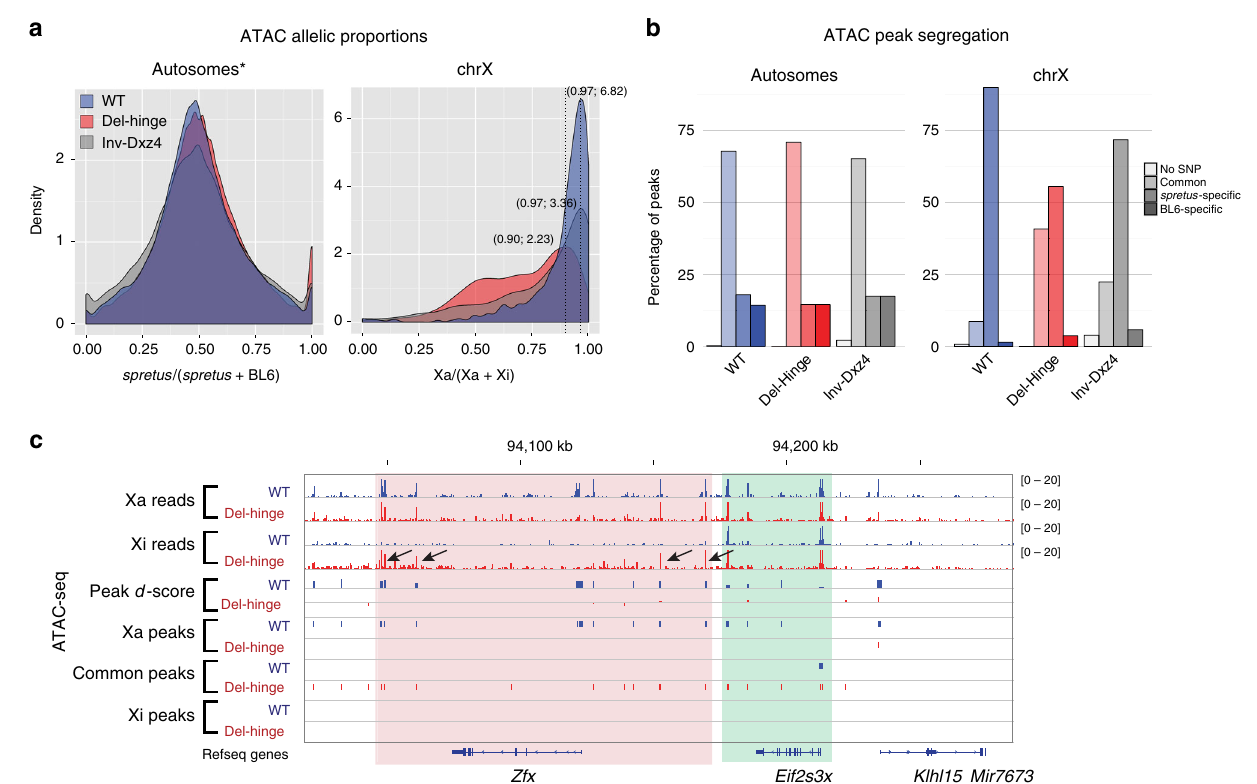
Fig. 7 ATAC peak distribution on the Xi in Del-hinge and Inv-Dxz4. a As in Fig. 6a but for ATAC peaks. A shift in the distribution of allelic proportions due to an increase in ATAC peaks on the Xi is evident for the X chromosome in Del-hinge and to a lesser extent Inv-Dxz4, compared to WT. b As in Fig. 6b but for ATAC peaks. c As in Fig. 6c but for ATAC peaks. Note that the location of peaks that appear around Zfx (arrows) in Del-hinge differ from that of the CTCF peaks. See additional analyses in Supplementary Fig. 7 – RNA-FISH for Xist showed that the majority of nuclei had one cloud in WT (90%), Patski2-4 (95%), Del-hinge (96%), and Inv- Dxz4 (89%) cells, indicating that Dxz4 deletion or inversion does not appear to disrupt Xist RNA coating on the Xi (Fig. 8g).